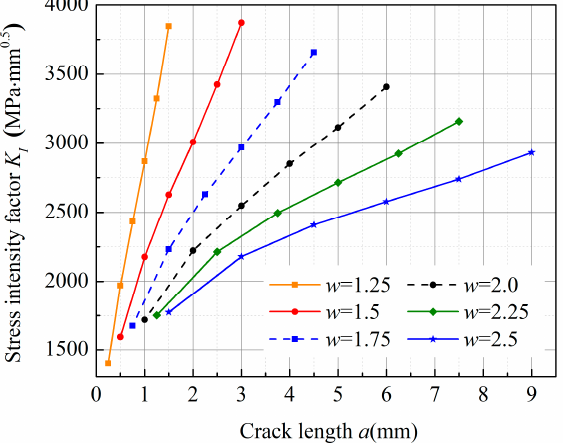
Figure 5. SIFs of different